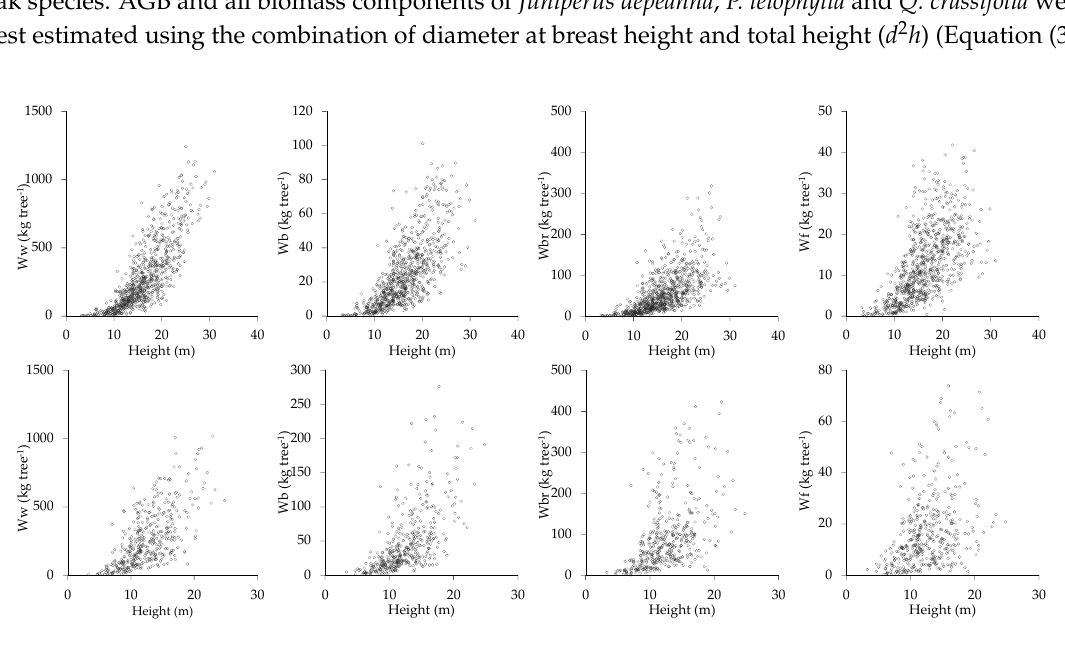
Figure 2. Relationships between the total height (m) and the tree biomass components stem wood ( W w ), stem bark ( W b ), branches ( W br ) and foliage ( W f ) (kg tree − 1 ).